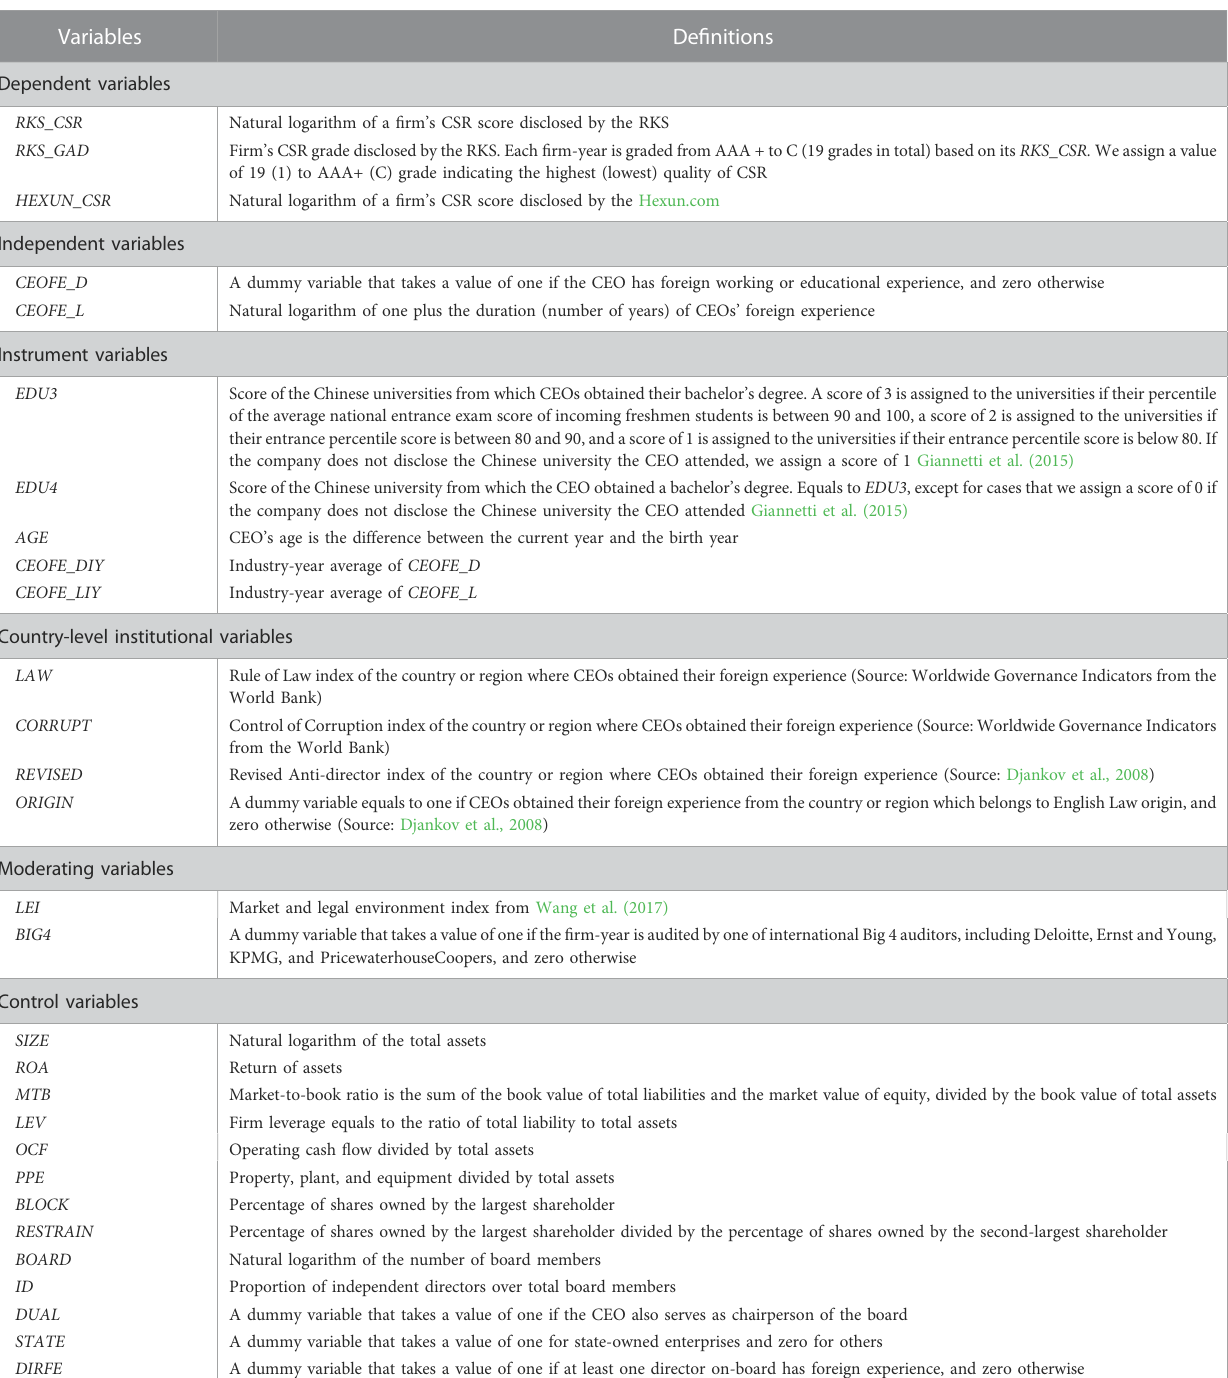
TABLE 1 De fi nitions of variables. Variables De fi